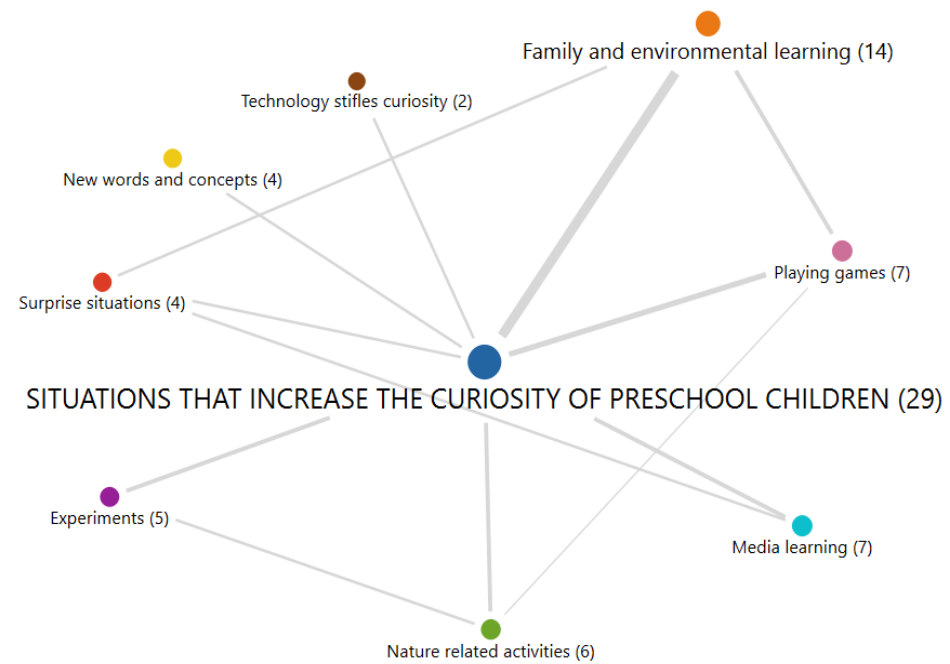
Figure 3. Situations that increase the curiosity of preschool children.